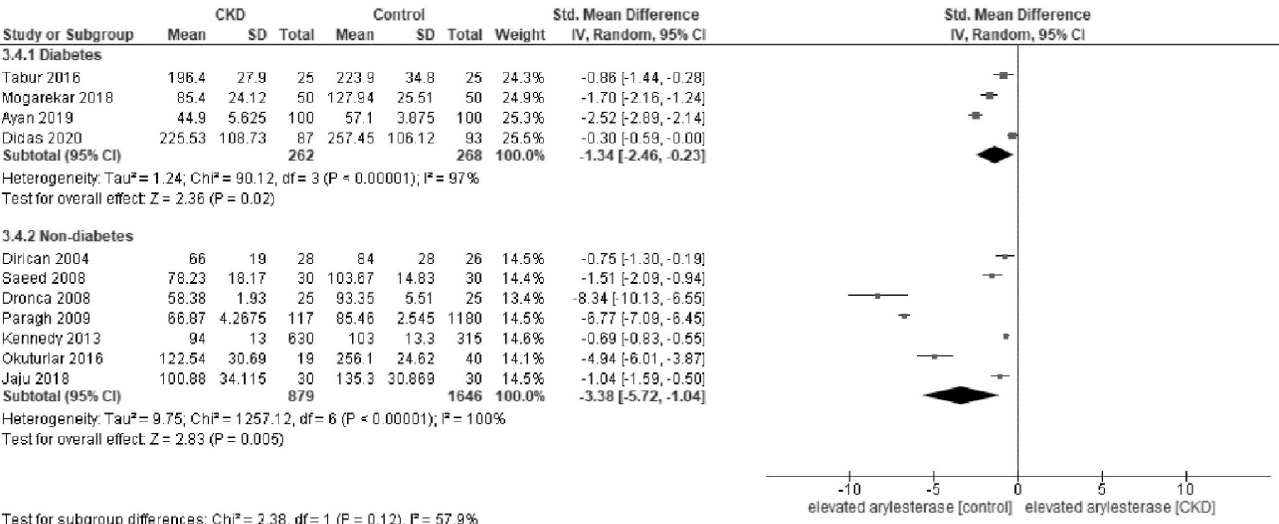
Figure A3. Forest plot of arylesterase activity stratified by diabetes status [28,30,32,34,39,41–43,45– 47].